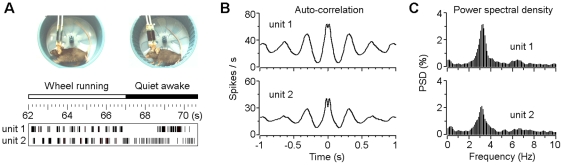
Rhythmic activity of VTA non-DA neurons during wheel running.(A) Rasters of two simultaneously recorded VTA non-DA neurons during voluntary wheel running and quiet wakefulness. (B and C) Auto-correlation and power spectral density (PSD) analyses suggest that the same two neurons (as shown in A) showed strong rhythmic activity (at a cycle of 0.31 sec on average) during wheel running.